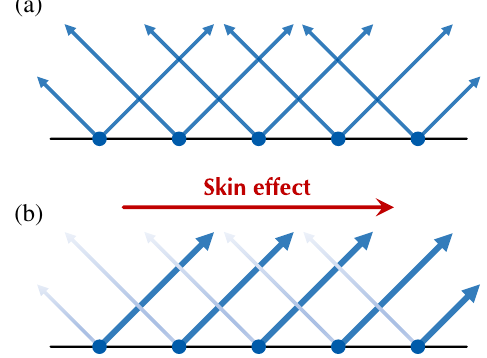
FIG. 1. Quasiparticle propagation in closed and open quantum systems. (a) Closed quantum systems. Quasiparticles propagate in both directions and diffuse throughout the system, leading to the volume law of entanglement entropy. (b) Open quantum systems subject to the skin effect. Nonreciprocal dissipation makes quasiparticles move toward only one direction, sup- pressing the entanglement propagation and leading to the area law of entanglement